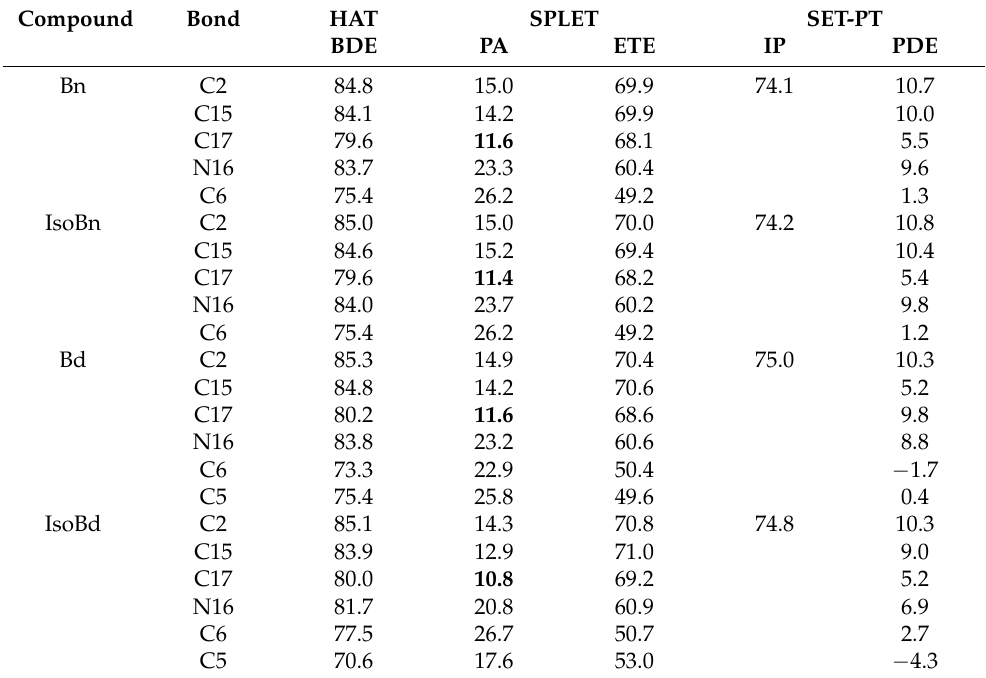
Table 1. Calculated BDE, PA, ETE, IP, and PDE values for compounds studied. Data in kcal/mol, at B3LYP/6-31+G(d,p) level of theory in